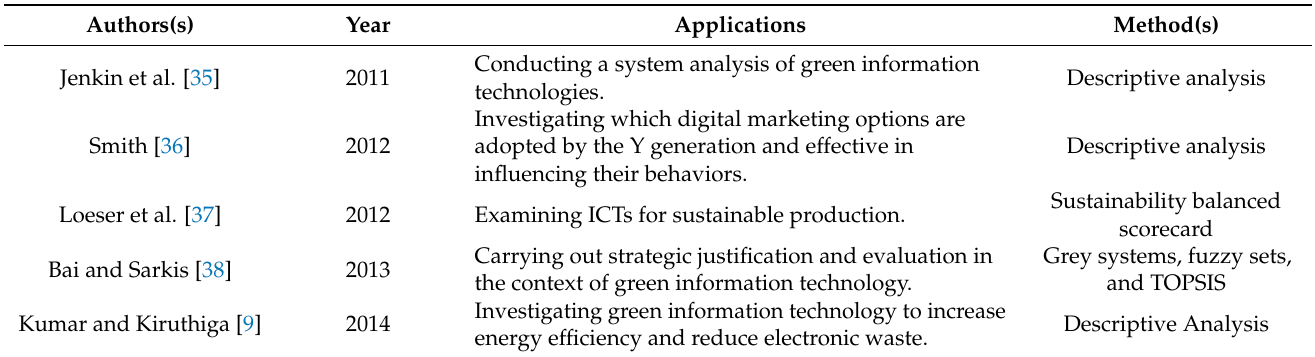
Table 1. Green approaches for ICTs and digital marketing